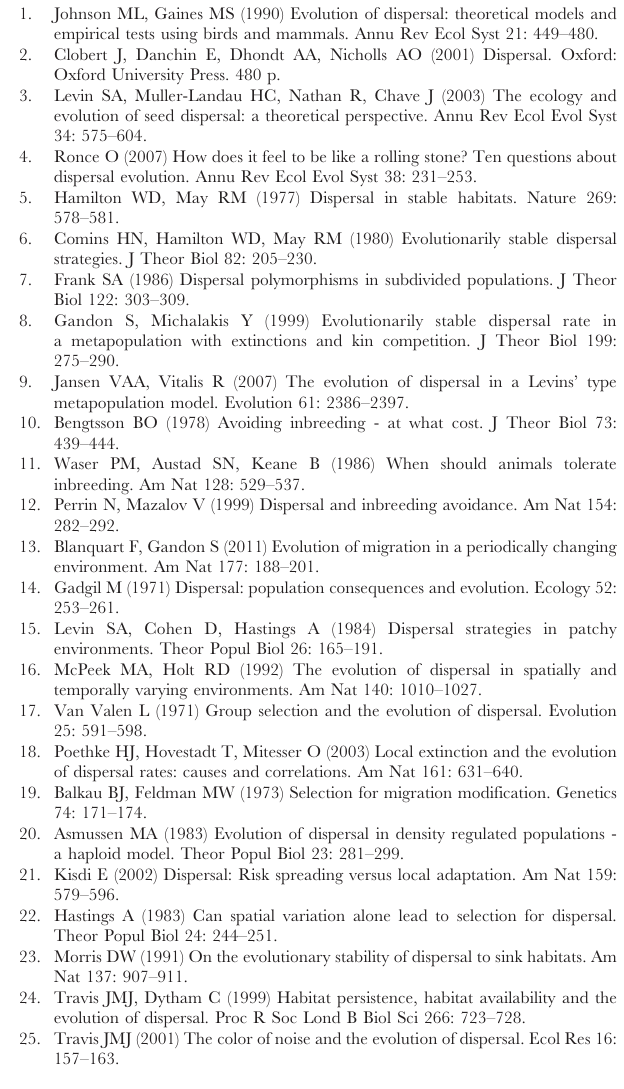
distribution of the n= 50 replicates. (TIF) Figure S2 Abundance of all the dispersal strategies for the specialist species. Mean abundances of the 101 specialist species ( s s = 0.05), computed on the n =50 replicates, as a function of species dispersal ability, across the various values of adult survival rate y s and disturbance rate T. Thick black line: a = 0; thin black line: a = 5; grey line: a = 10.